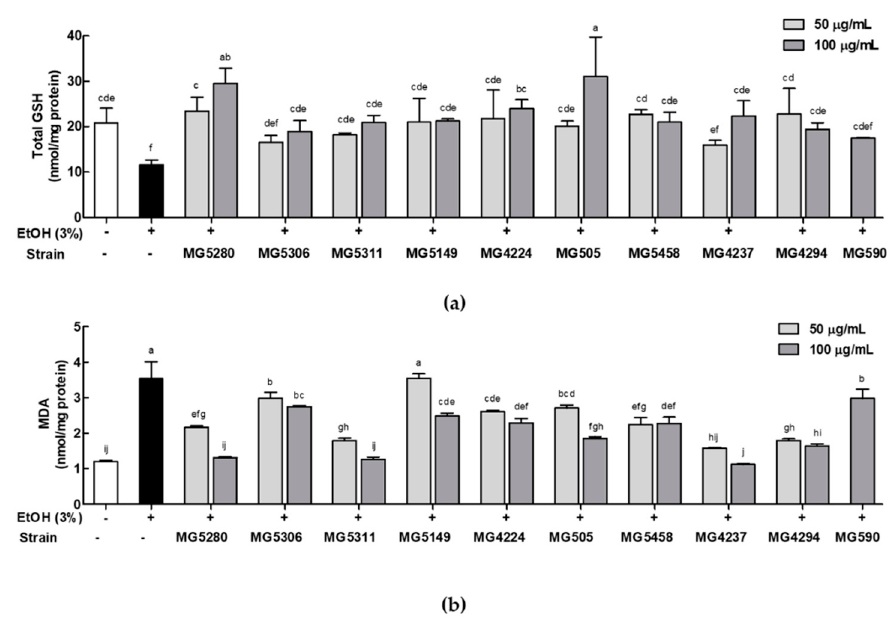
Figure 3. Effects of CFEs from LAB strains on ( a ) total GSH and ( b ) lipid peroxidation